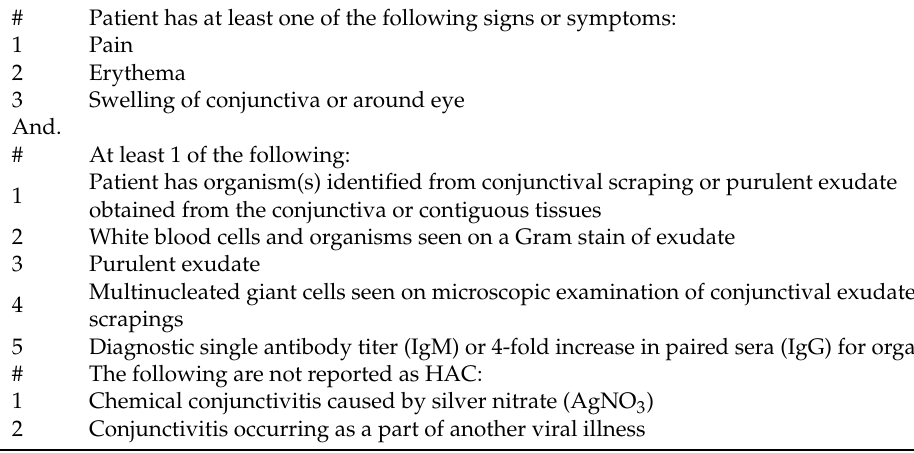
Table 1. CDC Criteria for HAC